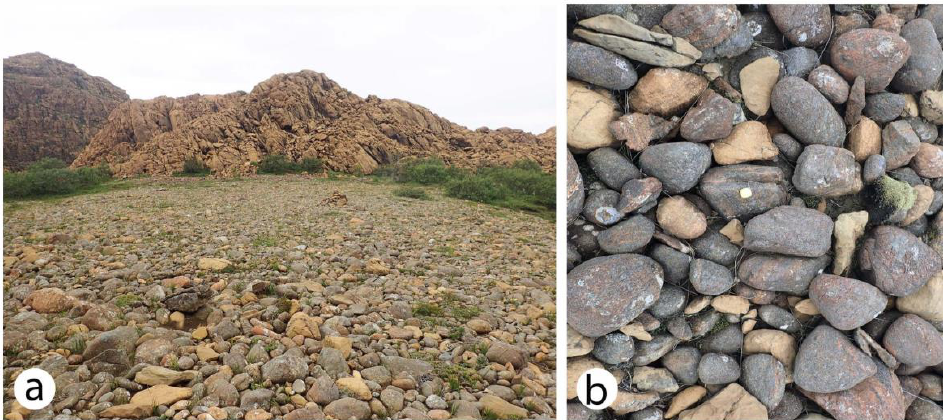
Figure 5. Details at the top of Støypet within a southwest to northeast (SW-NE) trending valley: ( a ) view to the northwest across the cobble-boulder field perpendicular to the trend of the valley and ( b ) close-up of cobbles and boulders dominated by chromite (darker rocks) with the clast at the center (marked by tape-measure case) having a diameter of 26 cm across the long axis.